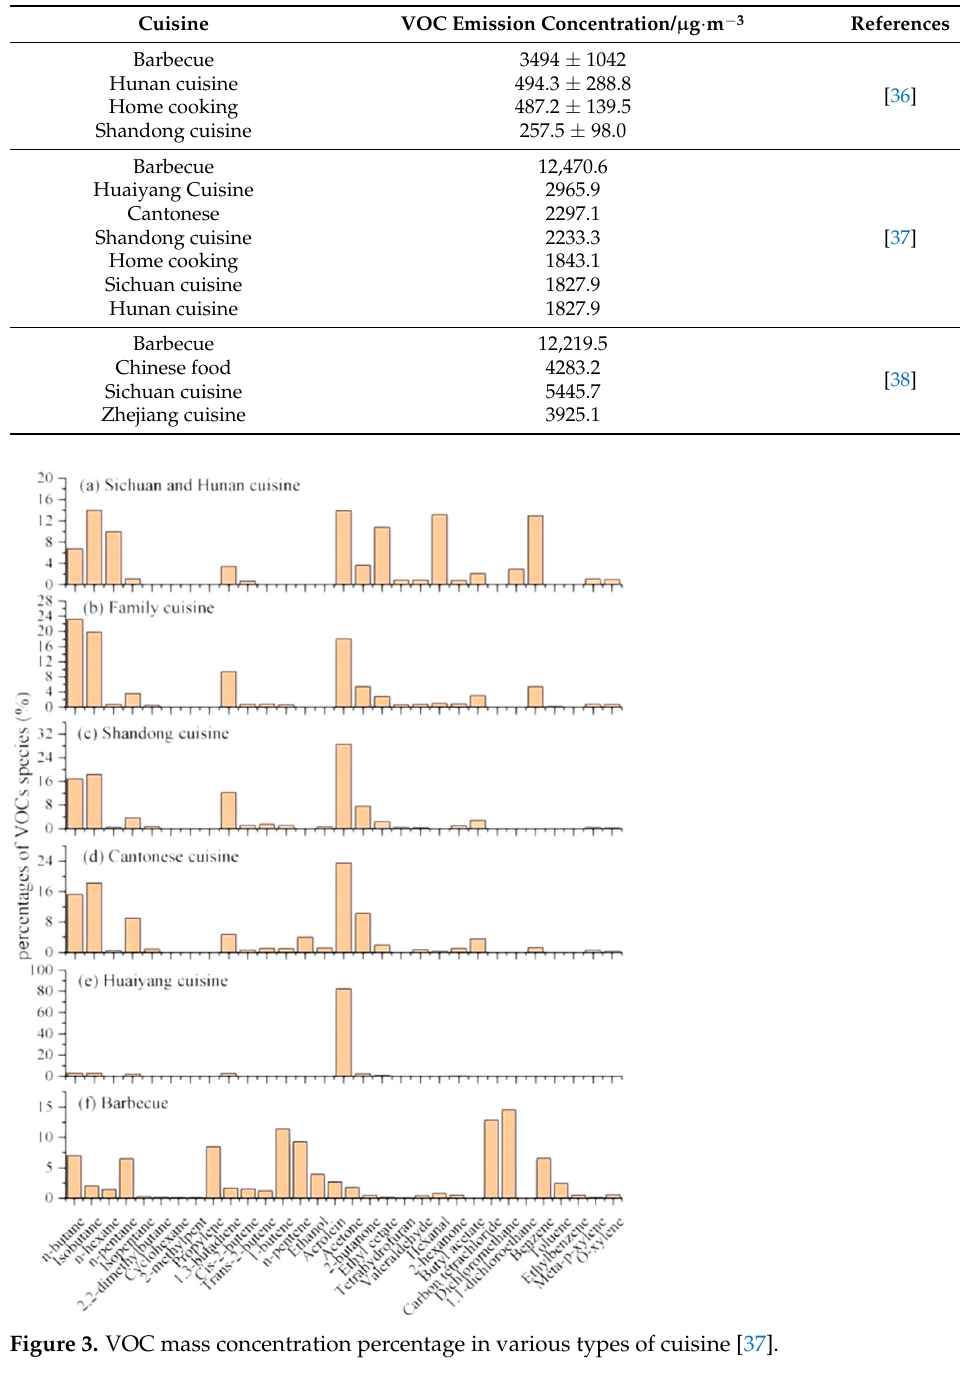
Figure 3. VOC mass concentration percentage in various types of cuisine [37].